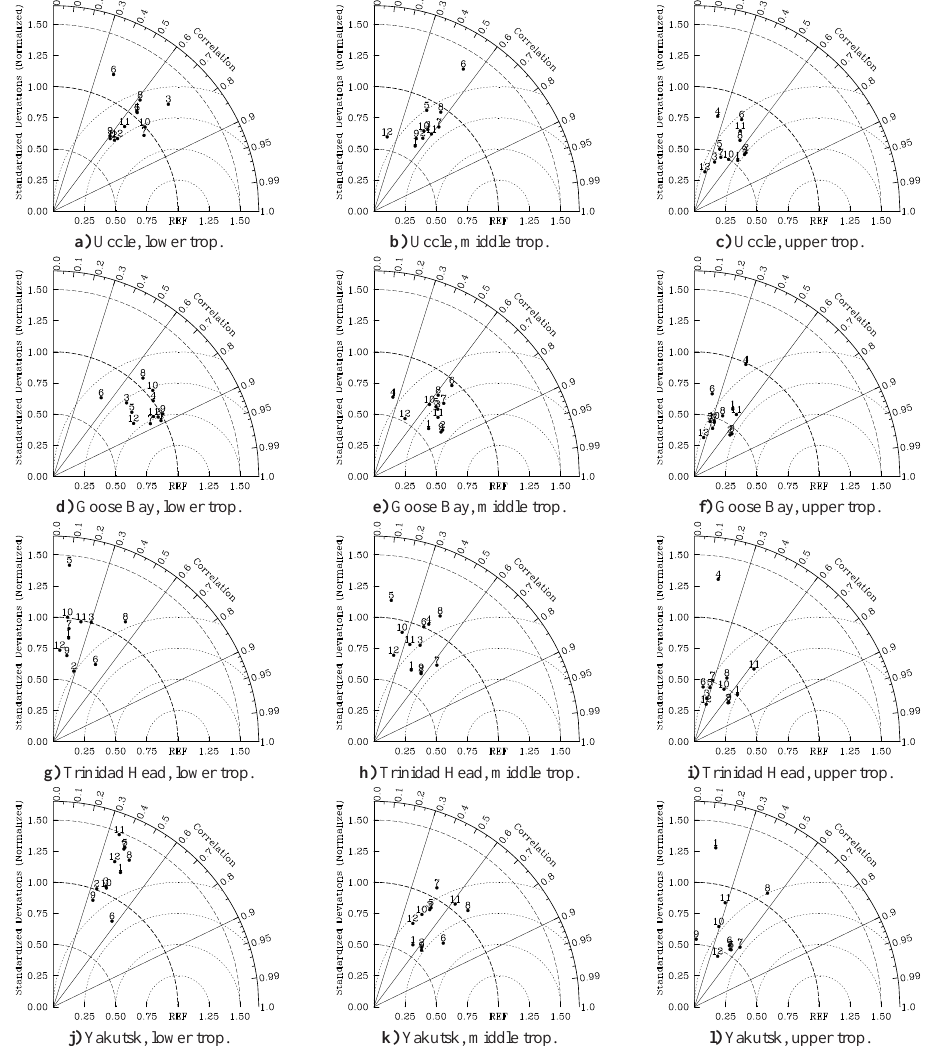
Fig. 11: Taylor diagrams showing correlations, normalised standard deviations (proportional to the radial distance from the origin) and RMS errors (proportional to the point on the x-axis identified as “REF”) for the comparison of ozone soundings and calculated vertical profiles for the 12 models listed in Table 1.